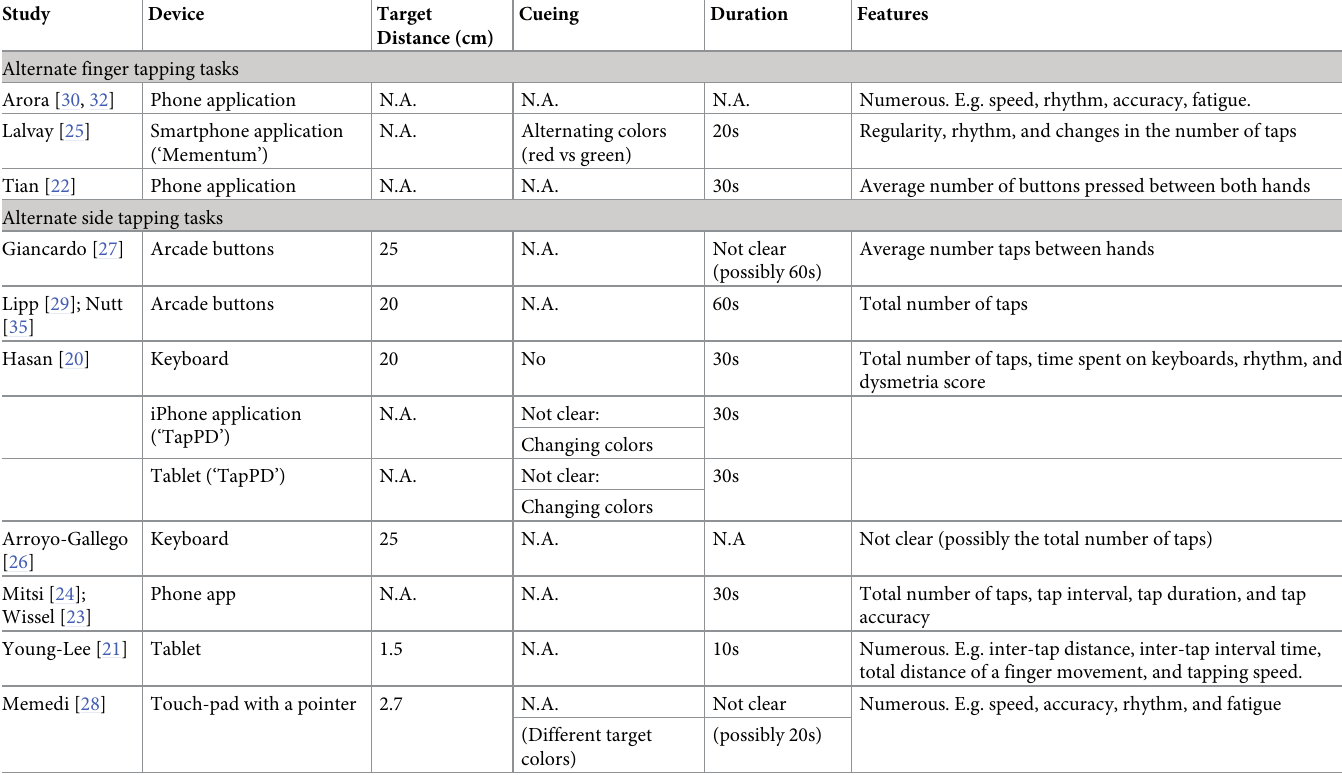
Table 1. Summary of the various finger tapping tasks found in the